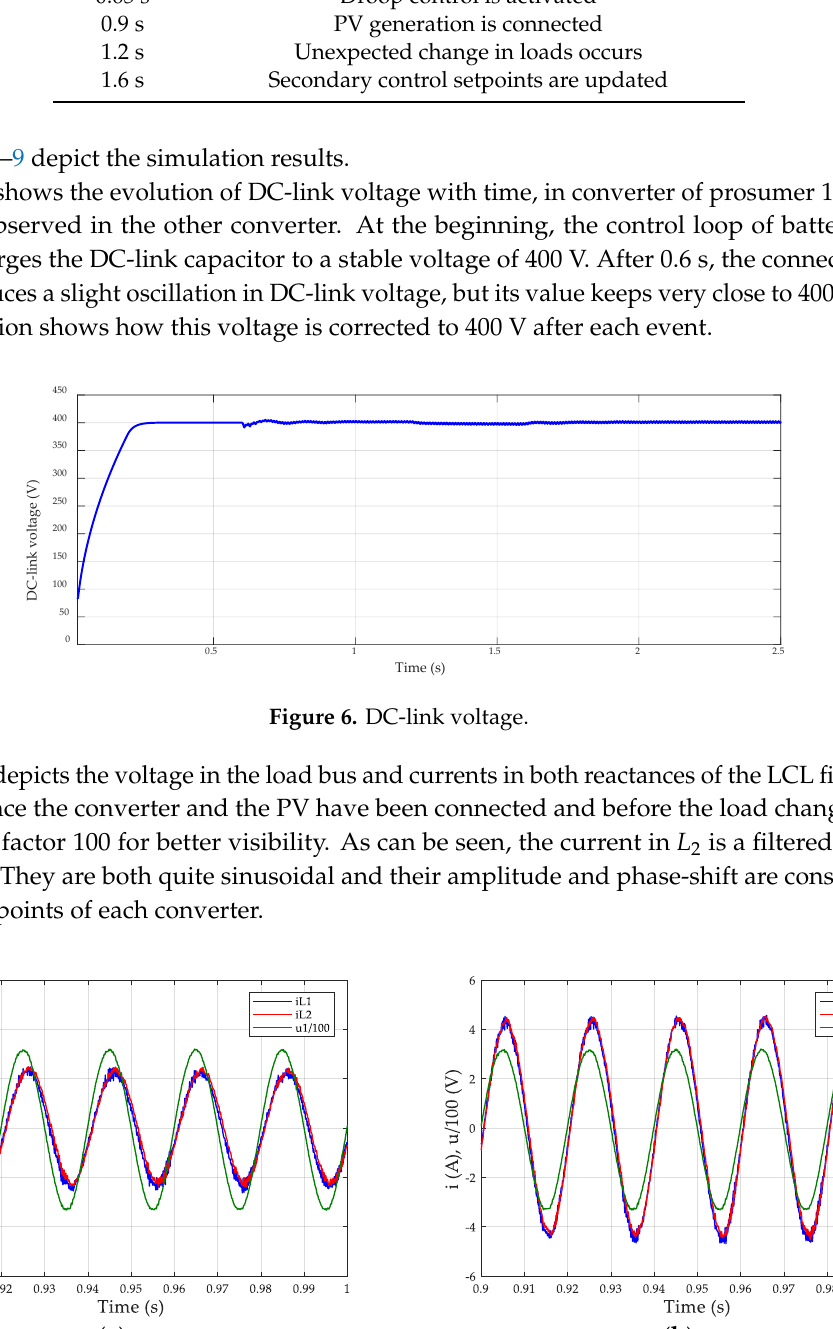
( b ) Figure 8. Droop control performance: ( a ) Voltage droop reference in the filter capacitor; and, ( b ) Frequency droop reference. Finally, Figure 9 shows the measured active and reactive power of both prosumers’ inverters. The power values are calculated from measured voltage in filter capacitors ( u ci ) and measured current in filter L 2 reactances ( i L 2 ). Setpoints for active and reactive powers in primary control ( P G-PRIMi and Q G-PRIMi ) are also depicted in the dashed line in the figure, under their calculated values. It can be observed that the calculated power values reach their initial setpoints once the inverter is connected, after a short transient period. Subsequently, loads change starting from 1.2 s of simulation and droop control shares increment in both active and reactive powers, pushing the calculated powers aside from setpoints. Once the setpoints are updated (1.6 s), the calculated power values reach again their new setpoints with a proper accuracy.